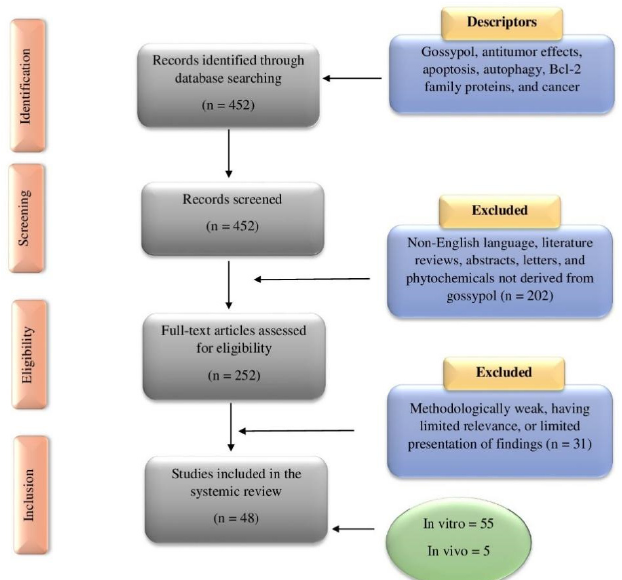
Figure 4. A PRISMA flowchart illustrating the literature search and study selection process relevant to the anticancer potential of gossypol. The total number of in vitro and in vivo studies [42] is greater than the number of studies included in this work [43] because many publications contained results from more than one organ-specific cancer or study type (in vitro or in vivo).